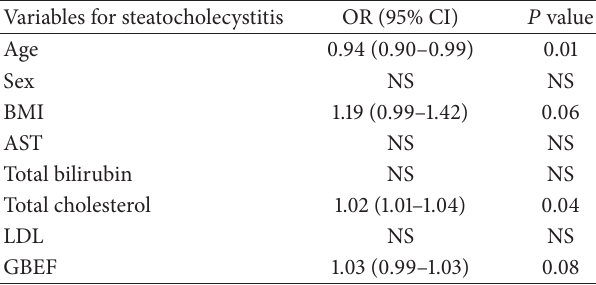
Table 4: Multivariable analysis for clinical risk factors of steatoc- holecystitis in patients with acalculous